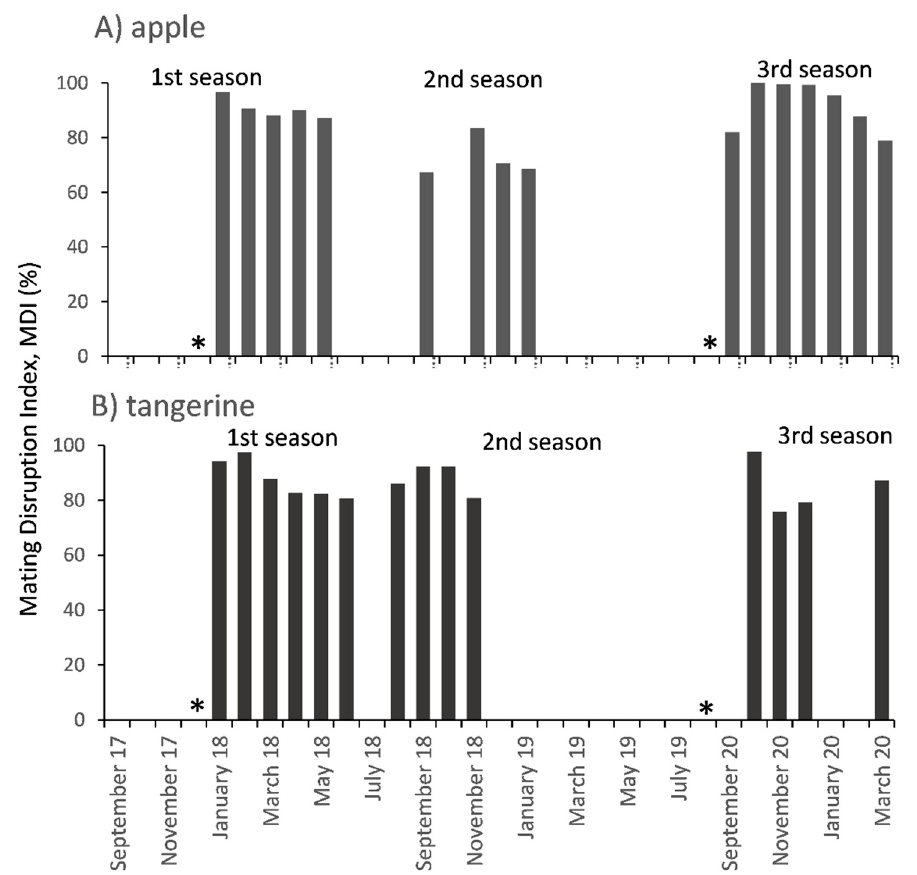
Figure 2. Mating Disruption Index (%), for the three seasons when male captures > 0.4 males × trap − 1 × day − 1 for the ( A ) apple and ( B ) tangerine orchards. * Date of pheromone application.